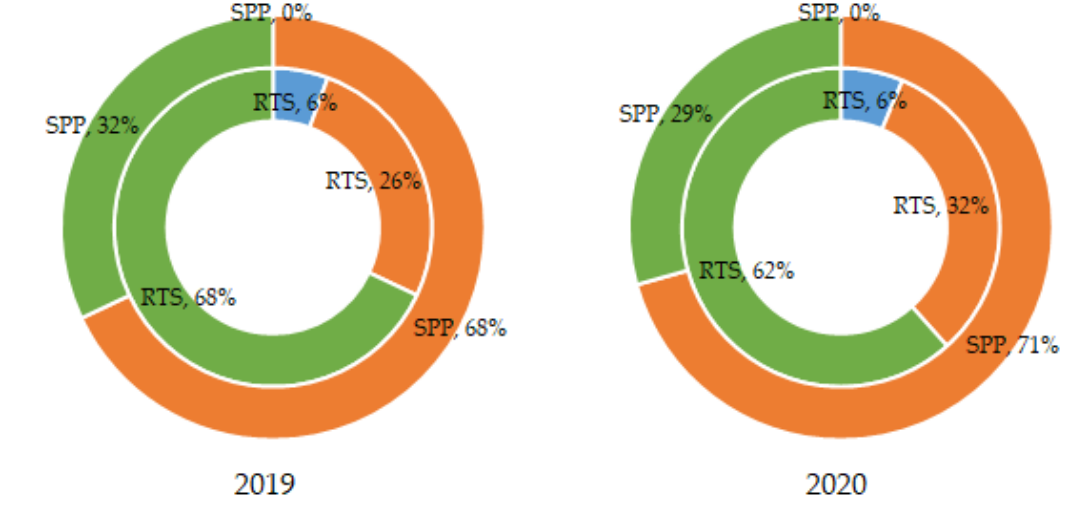
Figure 10. Share of new RTS and SPP according to region in 2019 and 2020. (Adapted from Refs.